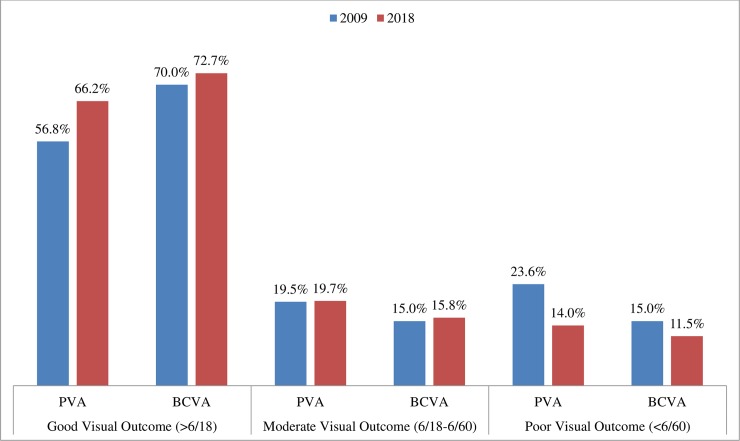
The comparision of cataract surgery visual outcome between 2009 and 2018.